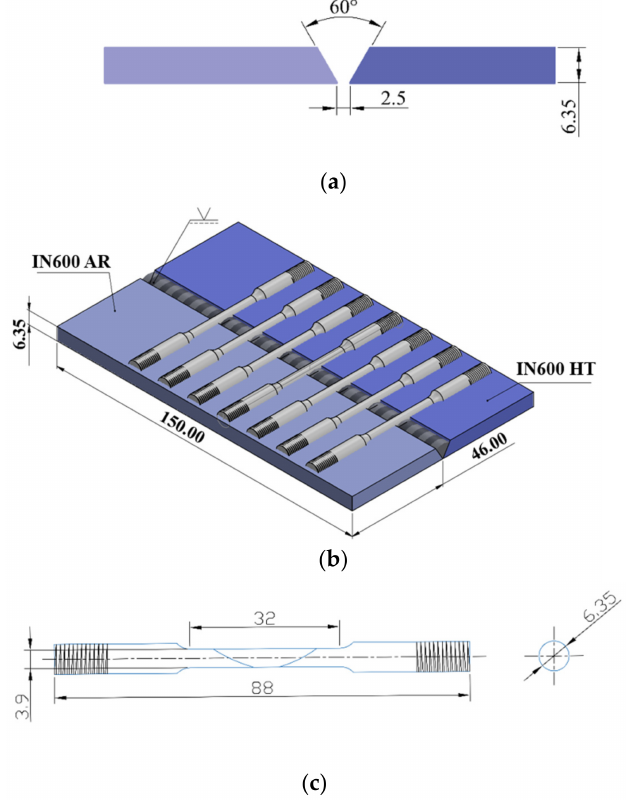
Figure 1. ( a ) Single-V groove joint design ( b ) schematic representation of the specimens machined for SCC and the ( c ) dimension and geometry of the SCC specimens. Dimensions in